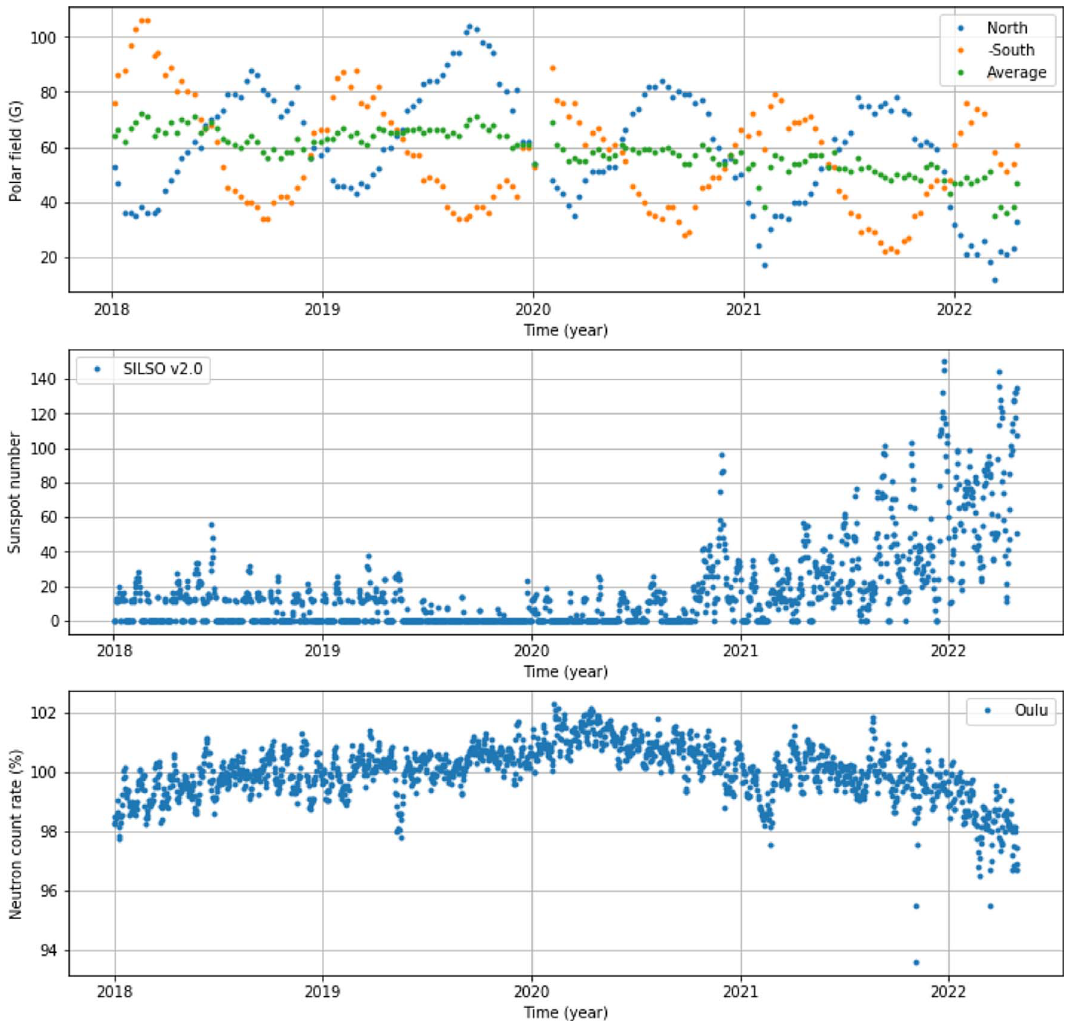
Figure 1. (a) The 10-day values of 30-day running averaged Sun ’ s polar magnetic fi eld, (b) daily mean sunspot number, and (c) daily mean neutron monitor count rate at Oulu, Finland. The polar magnetic fi eld strength (green dots) started decreasing in late 2019, while the neutron count rate started decreasing in early